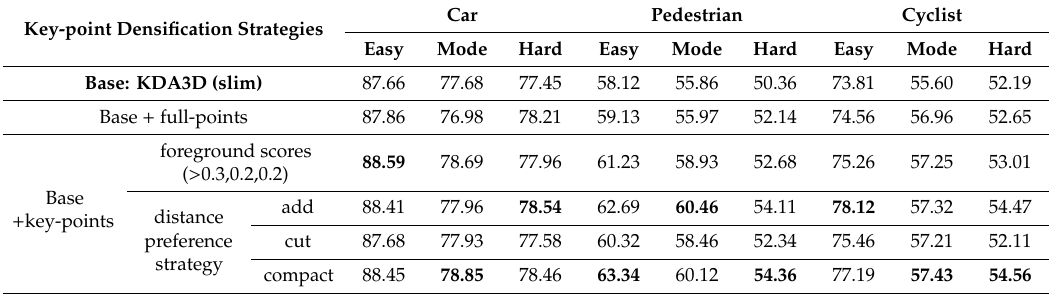
Table 3. 3D object detection performances of the detectors using di ff erent key-point densification strategies: Average Precision (AP 3D in %) of 3D boxes on KITTI’s val set. We use a 3D IoU threshold of 0.7 for the car class and 0.5 for the pedestrian and cyclist classes. The base detector is the KDA3D (slim). The strategy in the last row is KDA3D’s final choice.